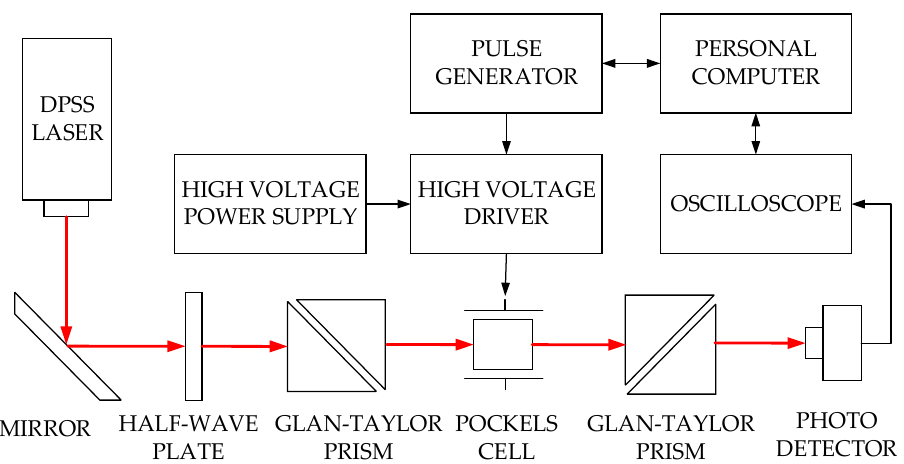
Figure 1. Single pass contrast ratio measurement setup, where DPSS - diode-pumper solid state. Bipolar high voltage power supply (PS2-60-1.4, Eksma Optics, Vilnius, Lithuania, 2015) was